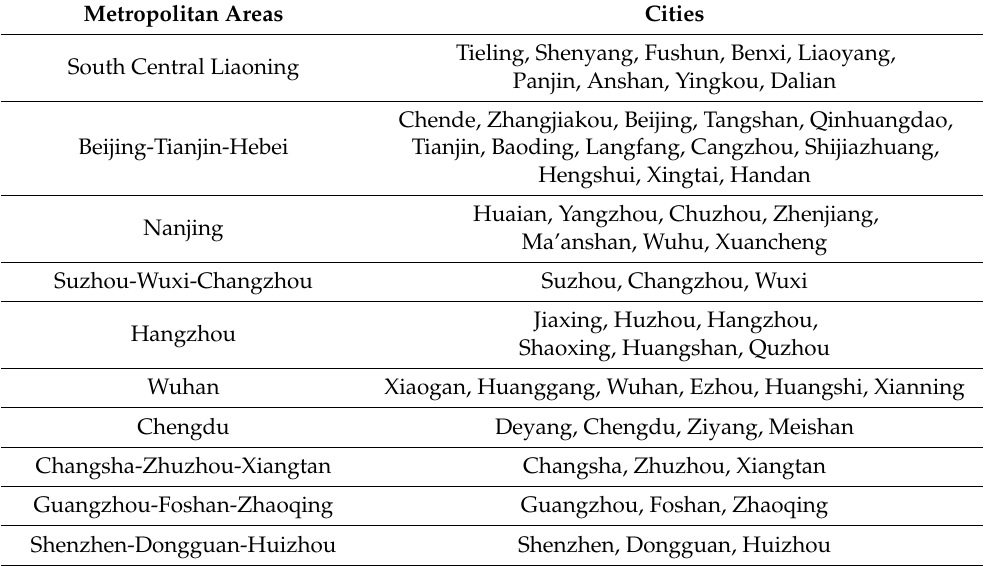
Table 1. Cities in ten metropolitan areas. Metropolitan